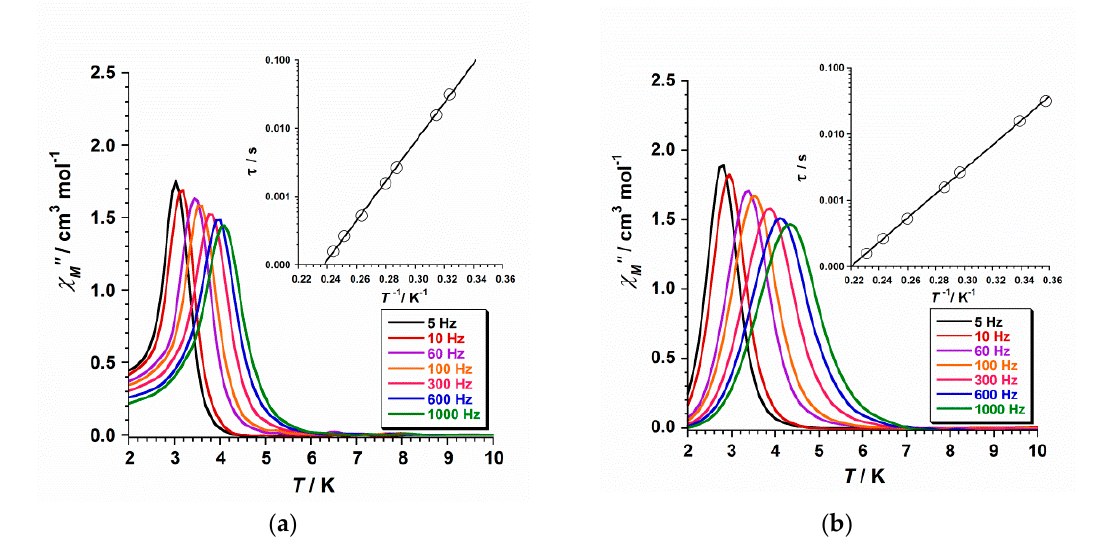
Figure 8. Out-of-phase AC susceptibility ( χ ” M ) versus T plots for compounds 1 ( a ) and 2 ( b ). The insets show the Arrhenius best-fit plot (see text).